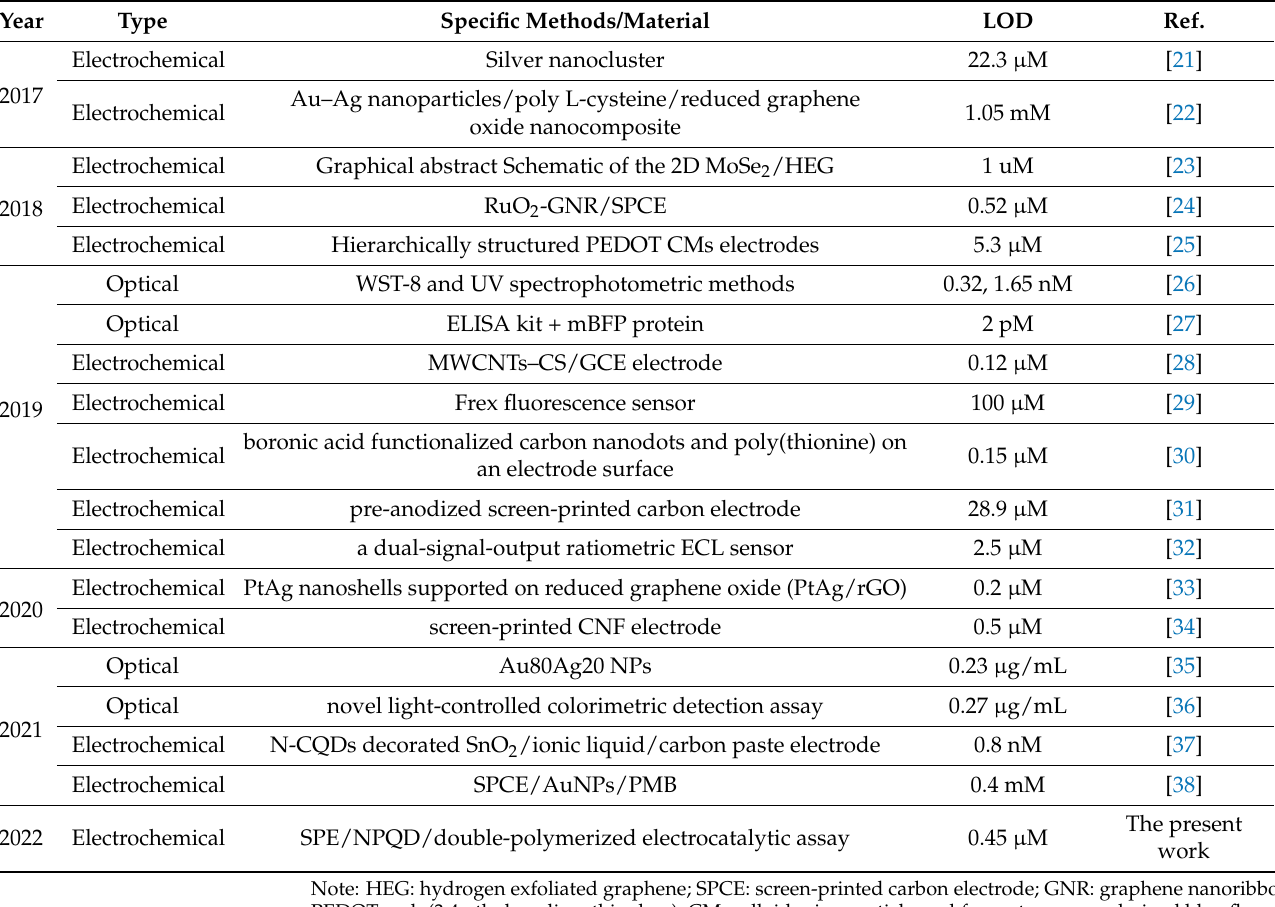
Table 1. Comparison of NADH detection with various analytical